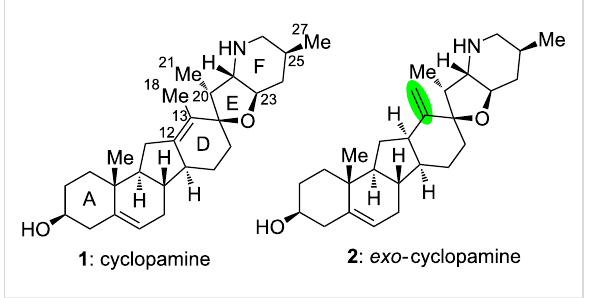
Figure 1: Structures of cyclopamine and exo